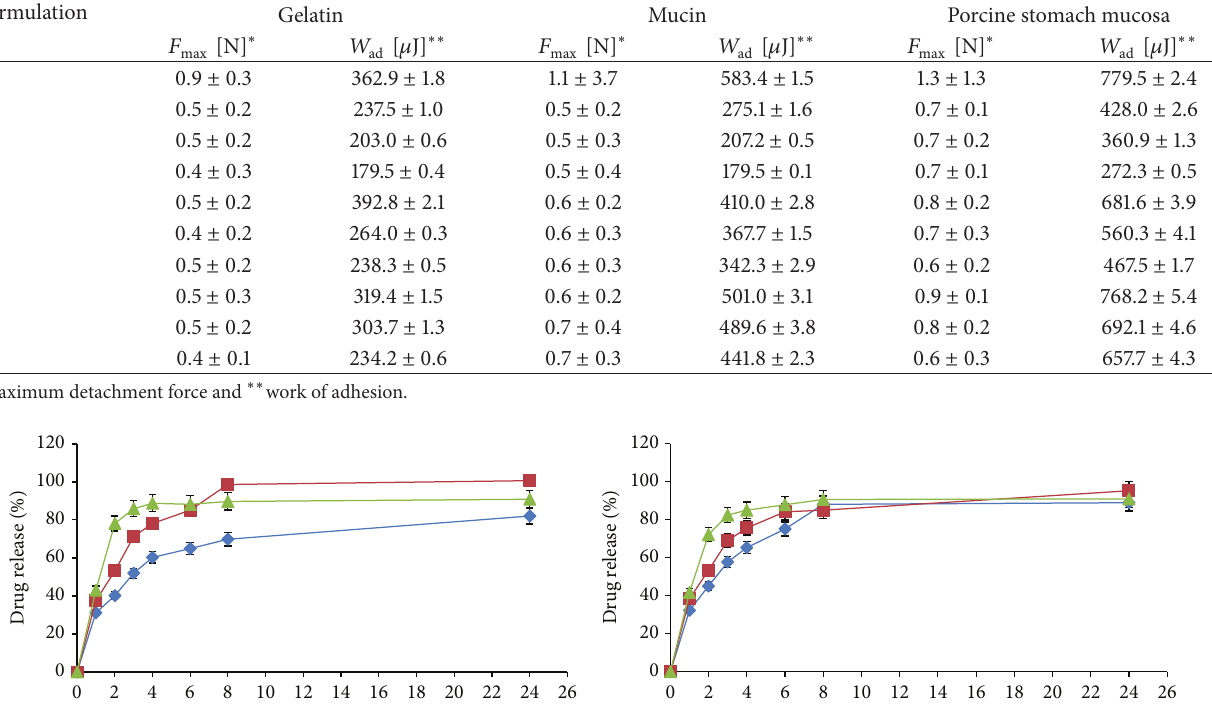
Table 2: Mucoadhesive properties of microspheres placebo (F0) and microspheres formulations F1–F9. Formulation